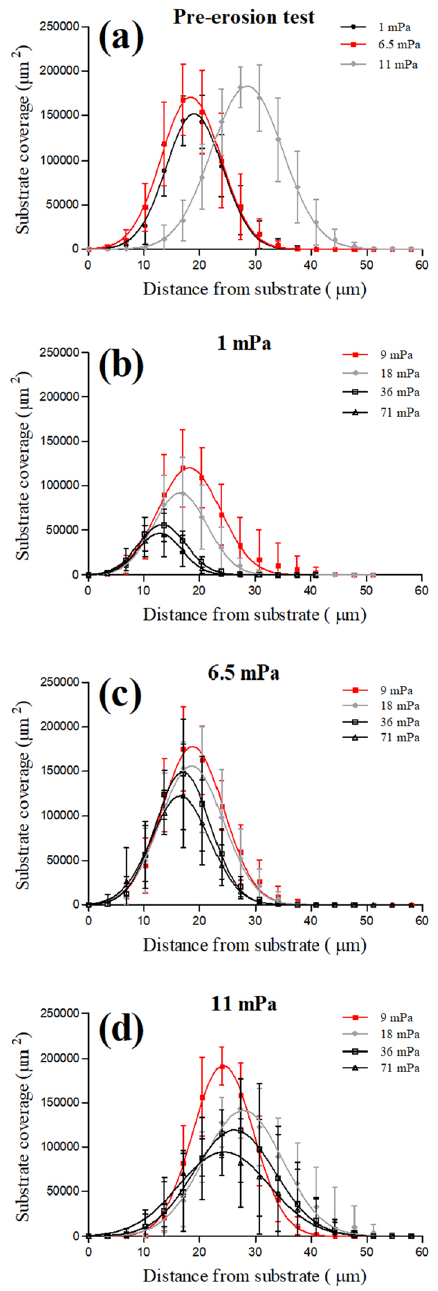
Figure 6. Vertical profiles of cell coverage in the biofilms during the erosion test. Panel ( a ) shows the vertical profile before the erosion test. Panels ( b – d ) show the vertical distribution of cells after the application of the erosion test for the biofilm grown at three hydrodynamic shears: 1.0, 6.5 and 11.0 mPa, respectively. The biofilms were subjected to an increasing set of shears (9.0, 18, 36, and 71 mPa), each step lasted for 10 min. Error bars represent the standard deviation (n ≥